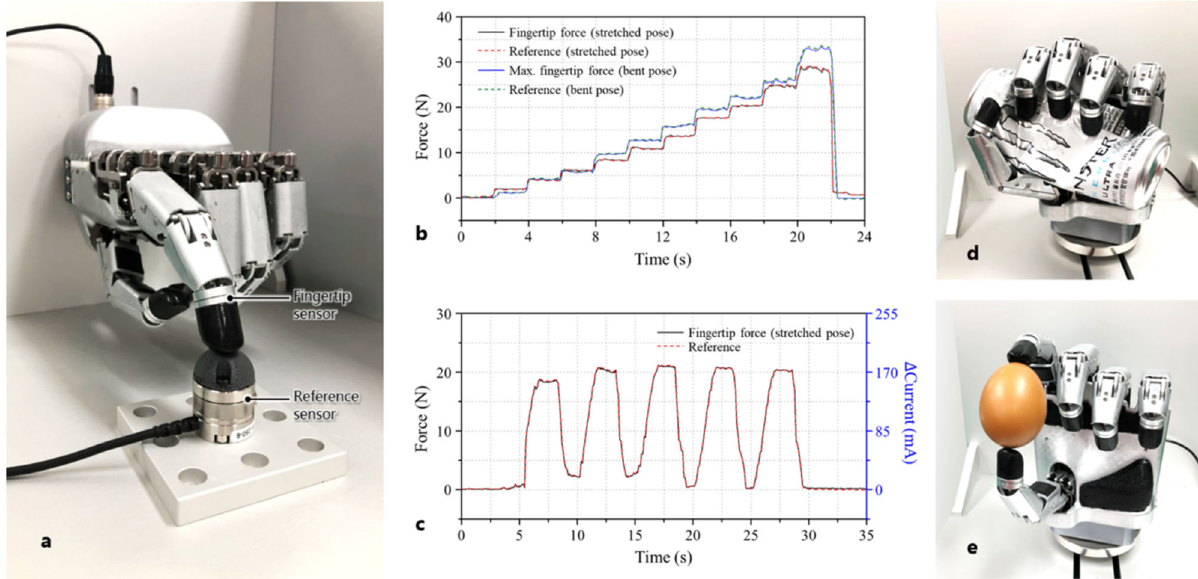
Fig. 6 Performance tests of the hand. a Experimental setup to evaluate fi ngertip force, control ability, and force-sensing performance of the developed hand. b Measured force data when the force applied by the fi ngers was sequentially increased stepwise. c Measured force data when applying the force